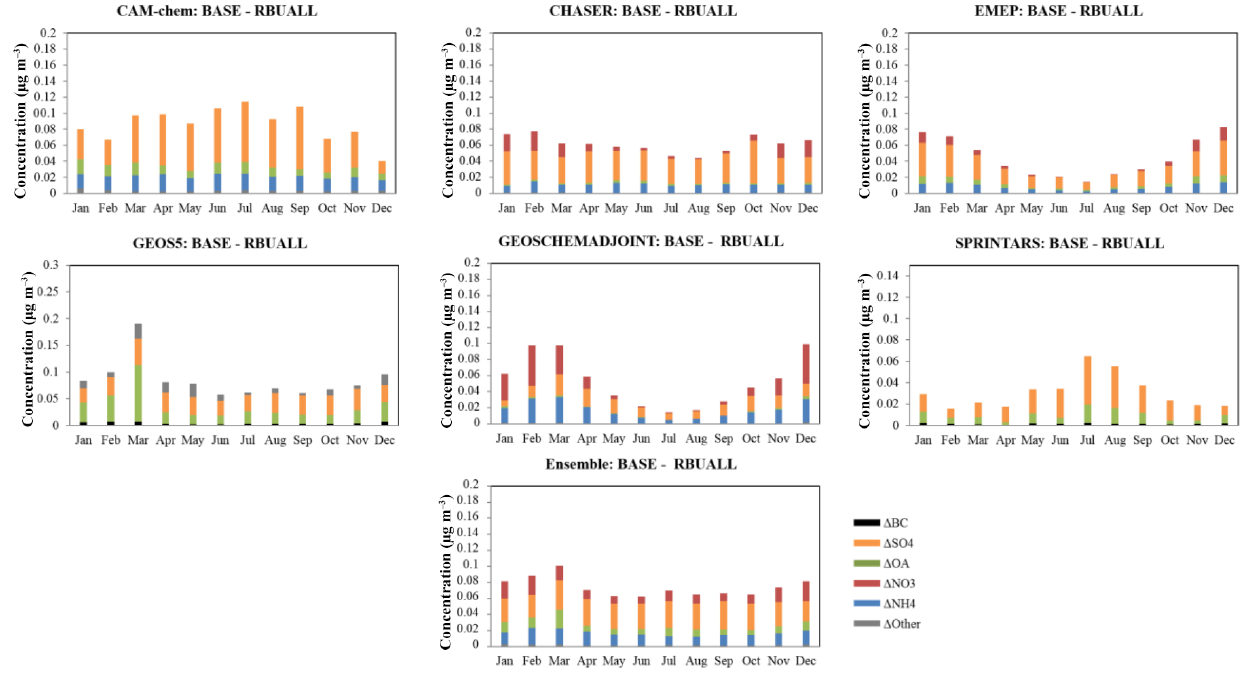
Figure 6. Same as Fig. 5 but under the RBUALL